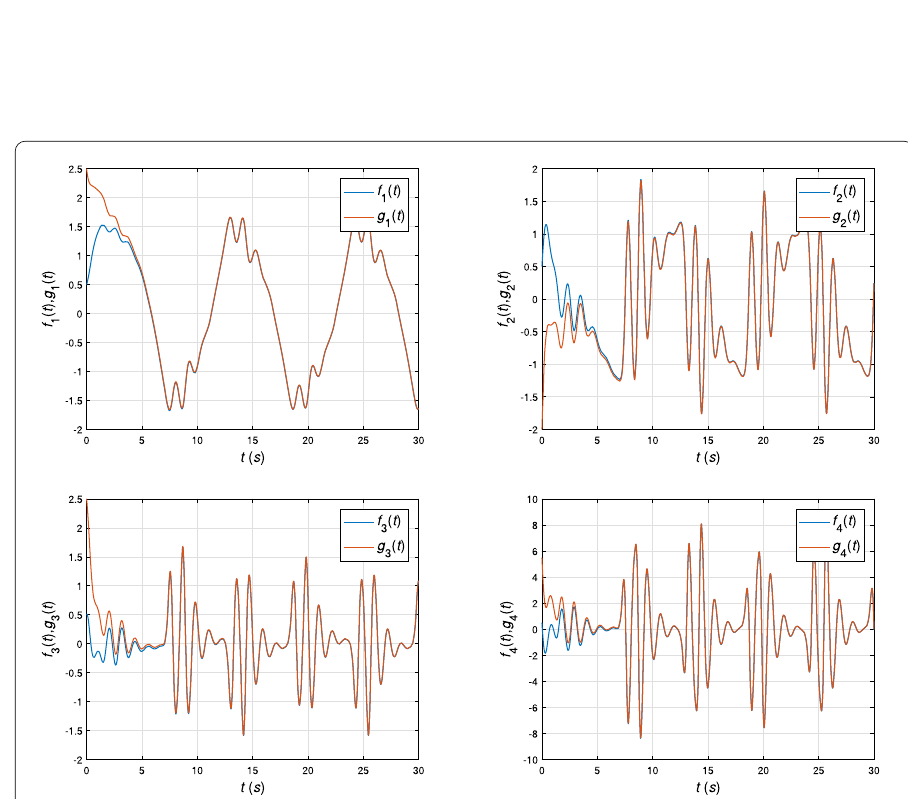
Figure 16 The state trajectories of the synchronized systems (19) and (20) for q =